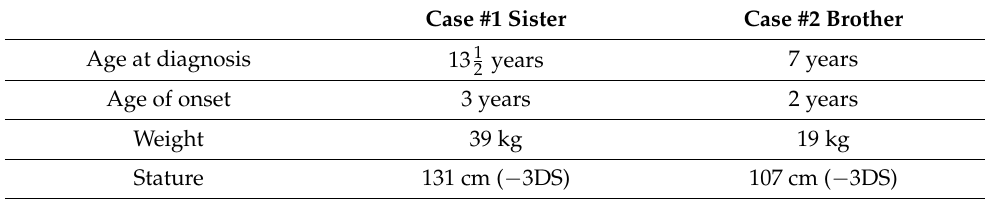
Table 1. Morphological evaluation of the patients at the initiation of treatment with